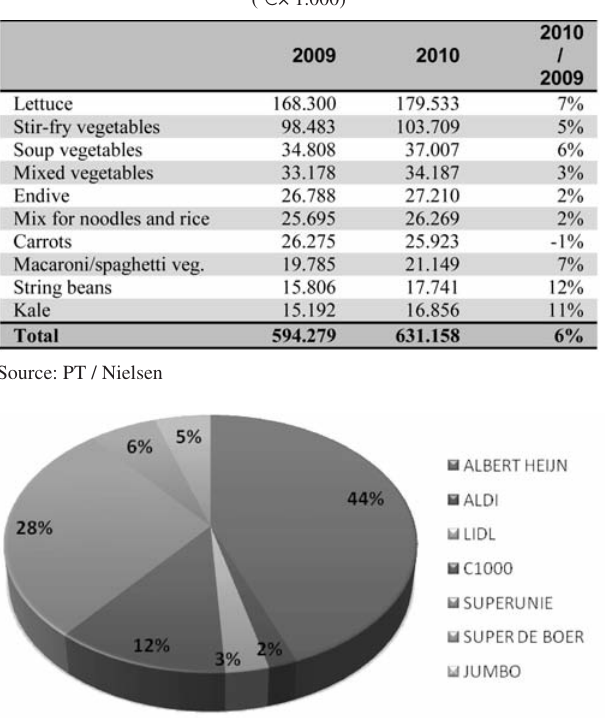
Table 7. Supermarket sales pre-treated fresh vegetables ( € × 1.000)